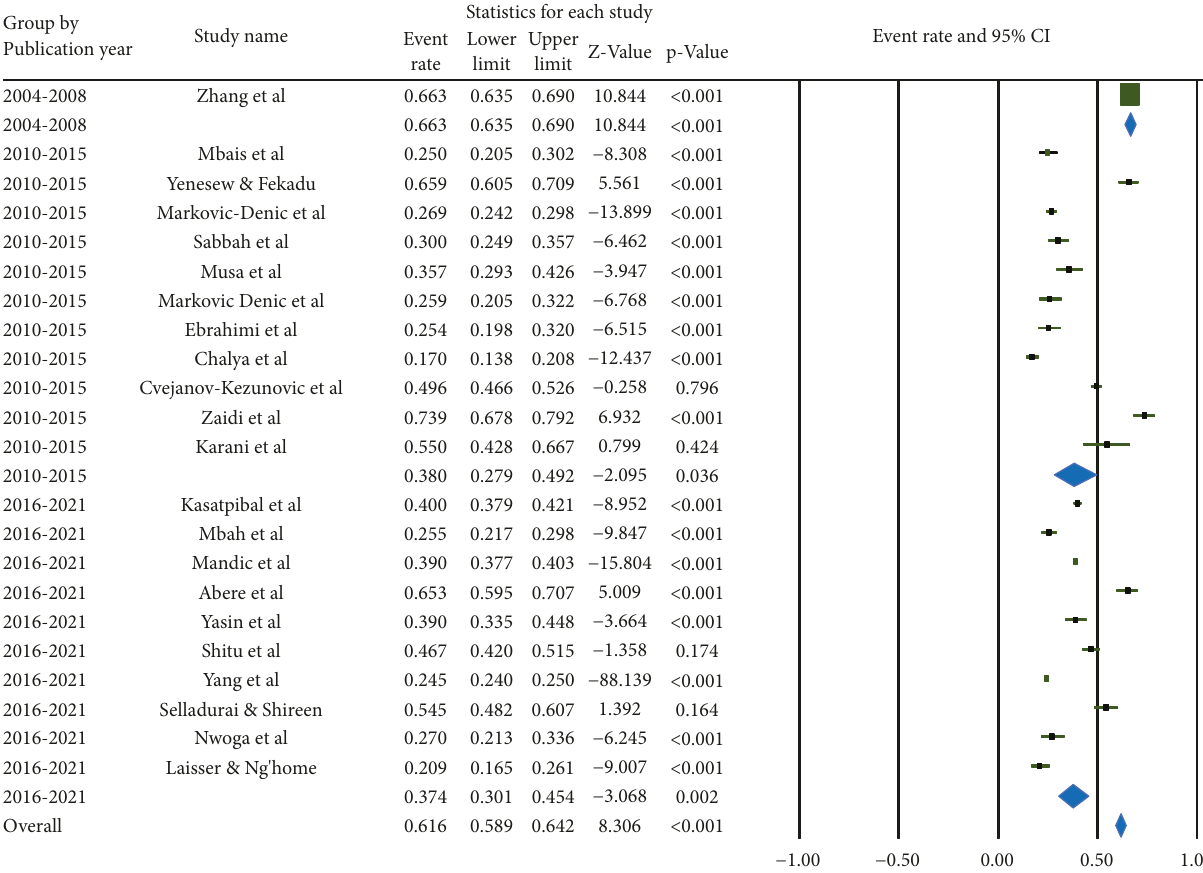
Figure 3: Pooled prevalence of occupational exposure to blood and body fluids in last 12 months among healthcare workers based on the publication